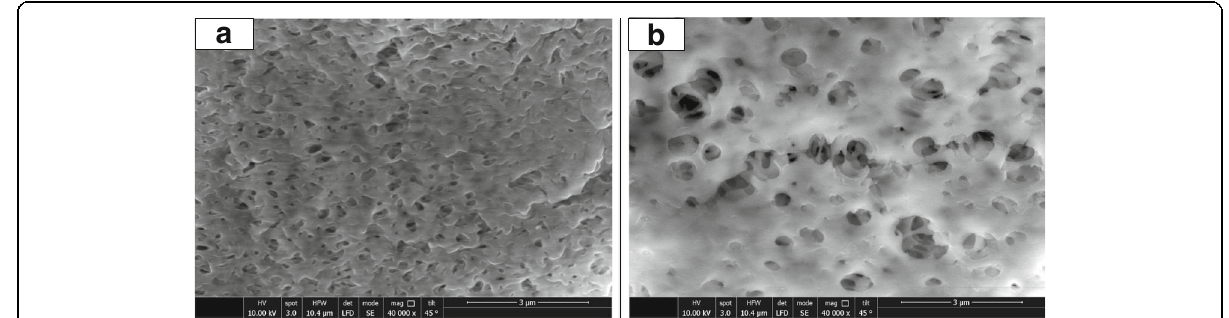
Fig. 2 SEM images at 40,000× of ( a ) untreated PES membranes and ( b ) DCM plasma treated PES